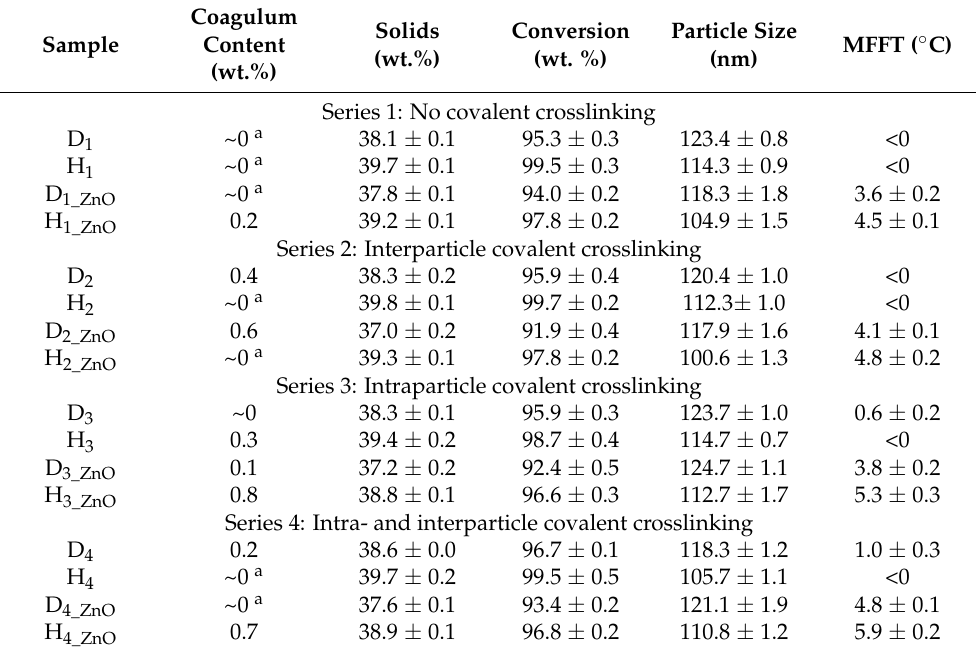
Table 4. Characteristics of latexes, differing in the covalent crosslinking strategy, surfactant type and the application of nanostructured ZnO